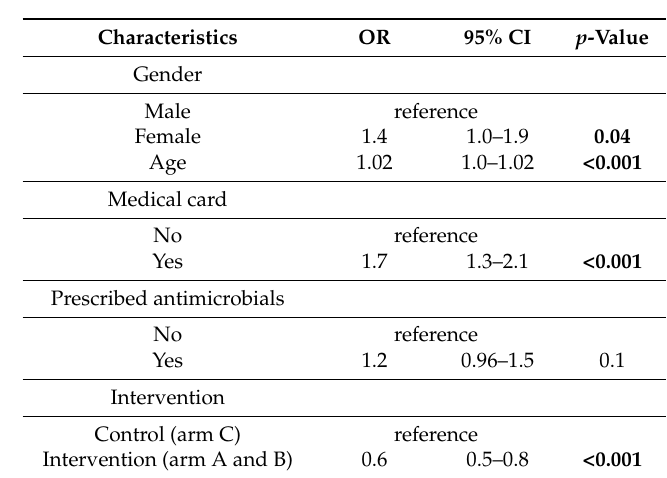
Table 2. Logistic regression of re-consultation for